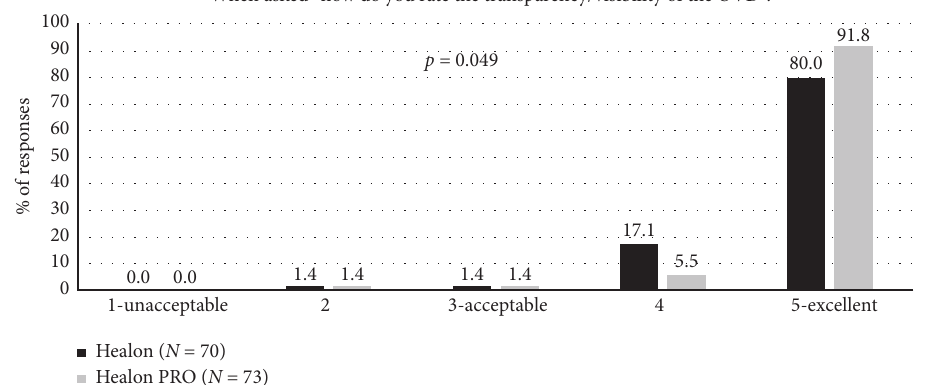
Figure 5: Transparency/visibility during surgery for the Healon control and Healon PRO test groups, where “user acceptable” indicated a response of “3,” “4,” or